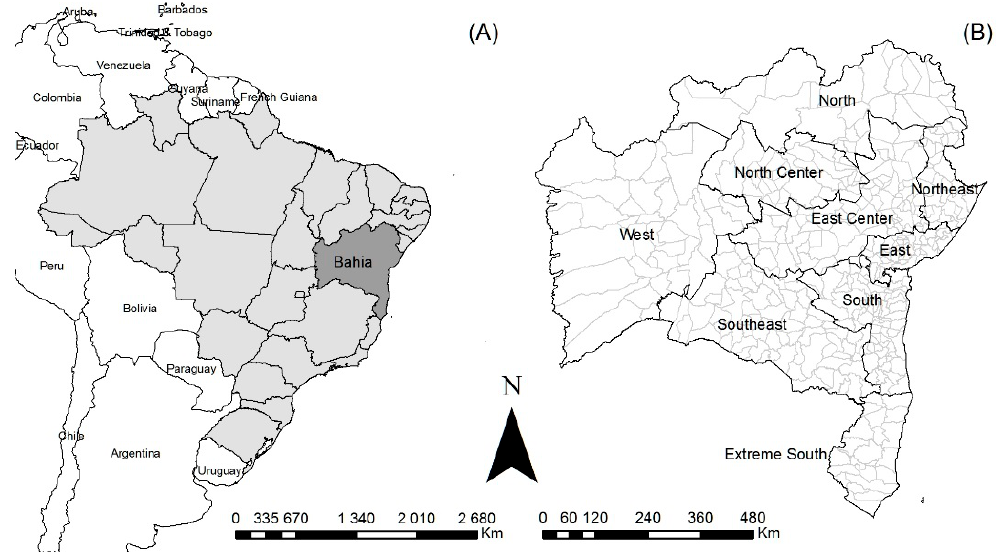
Figure 1. Study area: ( A ) location of the Bahia state; ( B ) Bahia state with its nine regions and 417 municipalities.